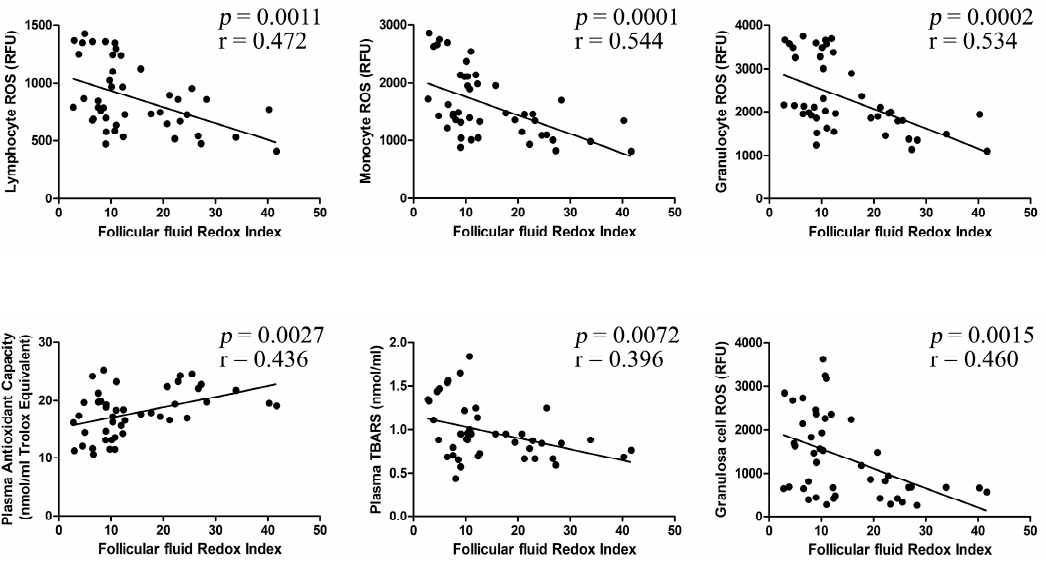
Figure 4. Follicular fluid redox index correlation analyses. Relationship among the investigated redox parameters and the follicular fluid redox index values. All of the correlation analyses were statistically significant at the p < 0.05 level.